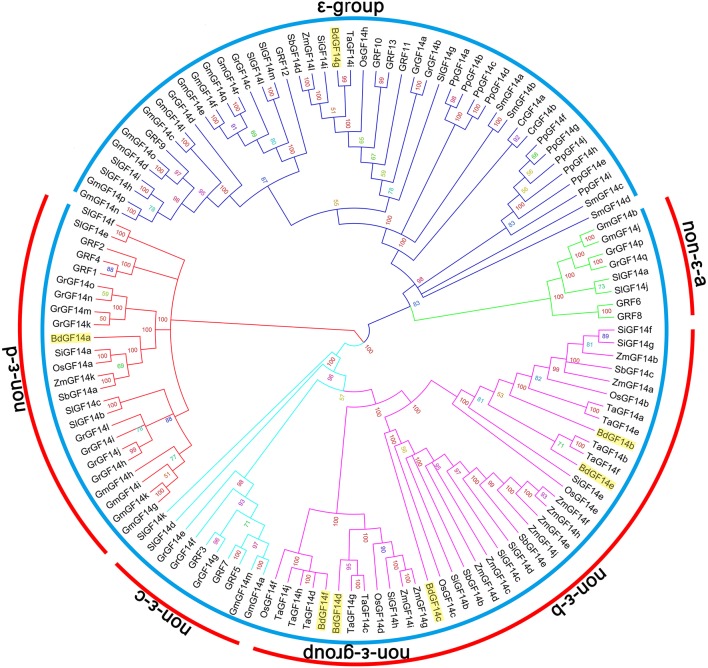
Phylogenetic relationships of plant 14-3-3 genes. A total of 127 complete protein sequences of the corresponding 14-3-3 genes obtained from 13 species from unicellular green algae to multicellular plants were aligned with MUSCLE program, and the phylogenetic tree was constructed based on Bayesian inference using Markov Chain Monte Carlo (MCMC) methods. The sky blue arcs indicate subgroups of 14-3-3 genes, while the red arcs indicate subfamilies of non-ε-group 14-3-3 genes. The 14-3-3 genes from B. distachyon are indicated by filled yellow rectangle.